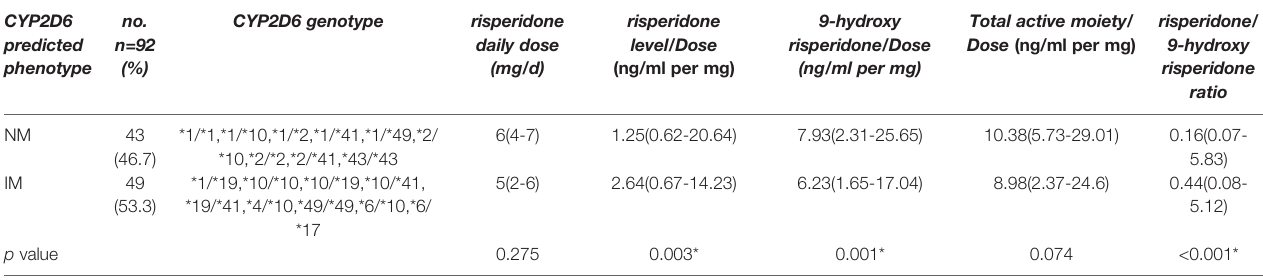
TABLE 3 | The relationship between CYP2D6 predicted phenotype and risperidone daily dose(mg/d), and dose-adjusted concentrations of risperidone, 9- hydroxyrisperidone, total active moiety, and risperidone/9-hydroxyrisperidone ratio (n =92). CYP2D6